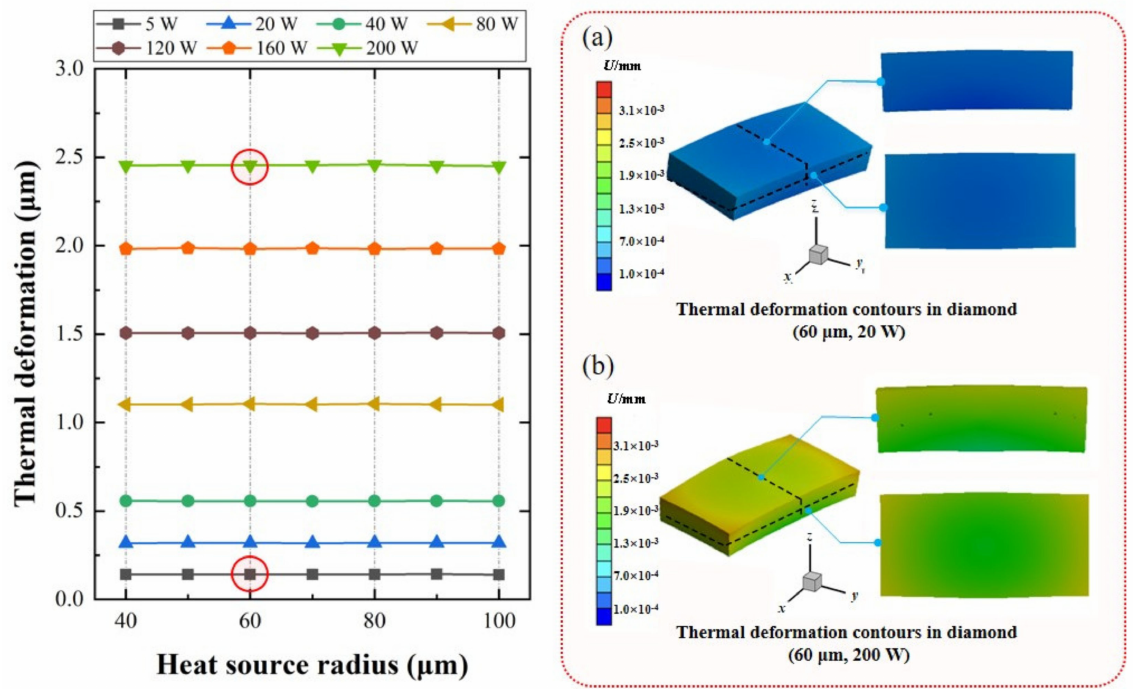
Figure 6. Thermal deformation contours in diamond with different power and heat source radius. Inset: ( a ) 20 W, and ( b ) 200 W with hear source radius of 60 µ m,